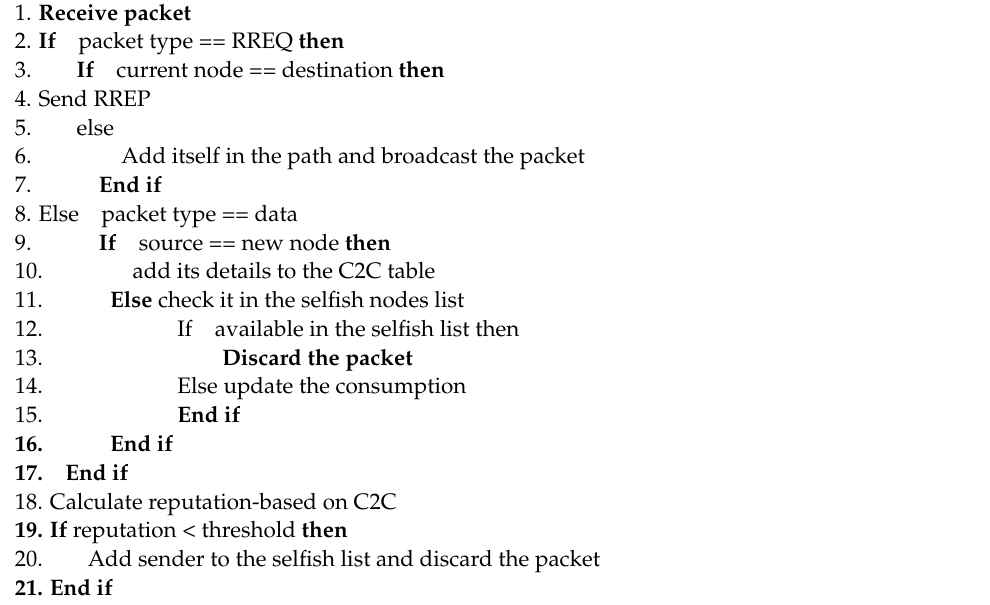
Algorithm 2. Reputation calculation for sender node ( S ) by intermediate node ( F )